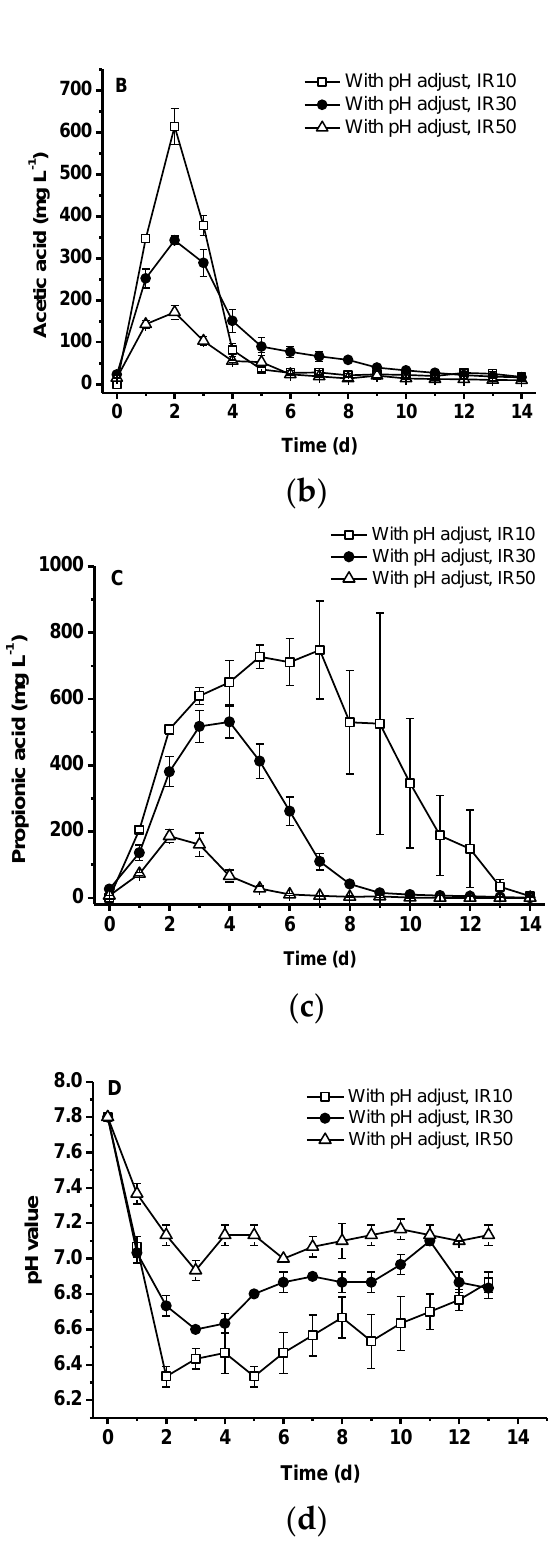
Figure 7. Effect of IR (pH adjusted to 7.8) on the concentrations of total VFAs ( a ), acetic acid ( b ), propionic acid ( c ), and pH values ( d ). Data indicate mean and its standard deviation of triplicates.